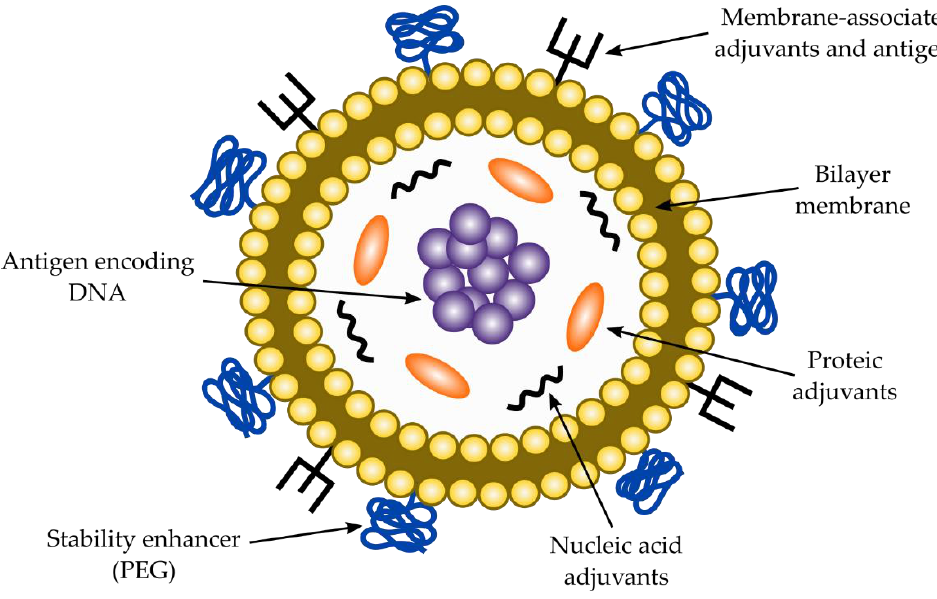
Figure 5. Schematic representation of a DNA liposome vaccine. The incorporation of the antigen- encoding DNA can be either in the aqueous inner space or by integration into the bilayer membrane, which will depend on the lipophilic properties of the compounds. Additionally, the liposome might carry PEG (stability), nucleic acid adjuvants (poly I:C, CpG), protein adjuvants (cytokines, immunostimulant molecules), membrane associated antigens and adjuvants (glycolipids, lipopeptides, cationic adjuvants) and the lipid bilayer membrane (cationic, anionic, or neutral). Note that mRNA can be also used to incorporate into liposomes to produce mRNA vaccines.